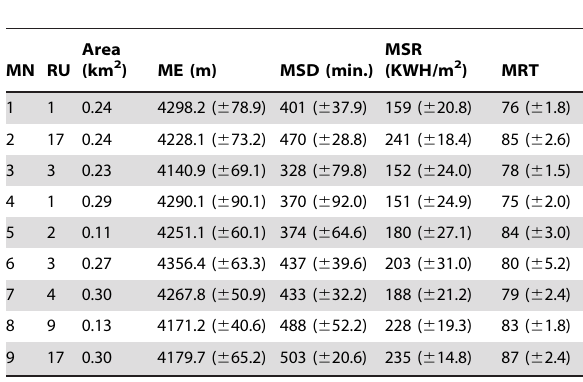
Table 1. Description of 9 MAPs identified as winter range for monkeys during winter of 2006–07 * .